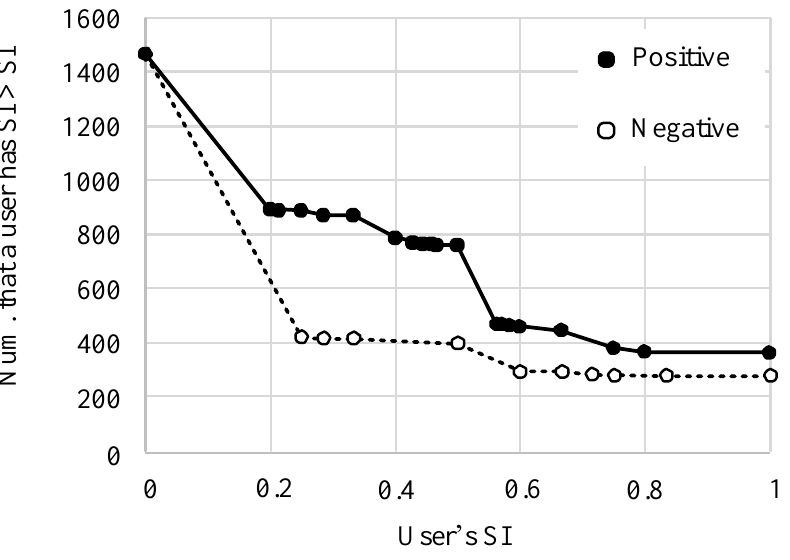
Figure 5. Complementary cumulative distribution of the user ’ s SI.